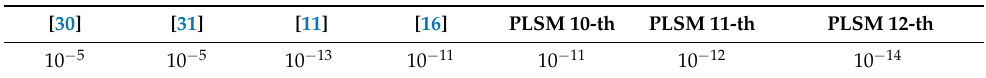
Table 4. Comparison of the order of the absolute errors of the approximate solutions for problem (25) corresponding to α =